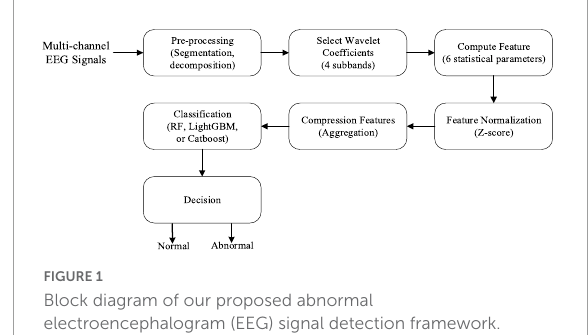
FIGURE1 Block diagram of our proposed abnormal electroencephalogram (EEG) signal detection